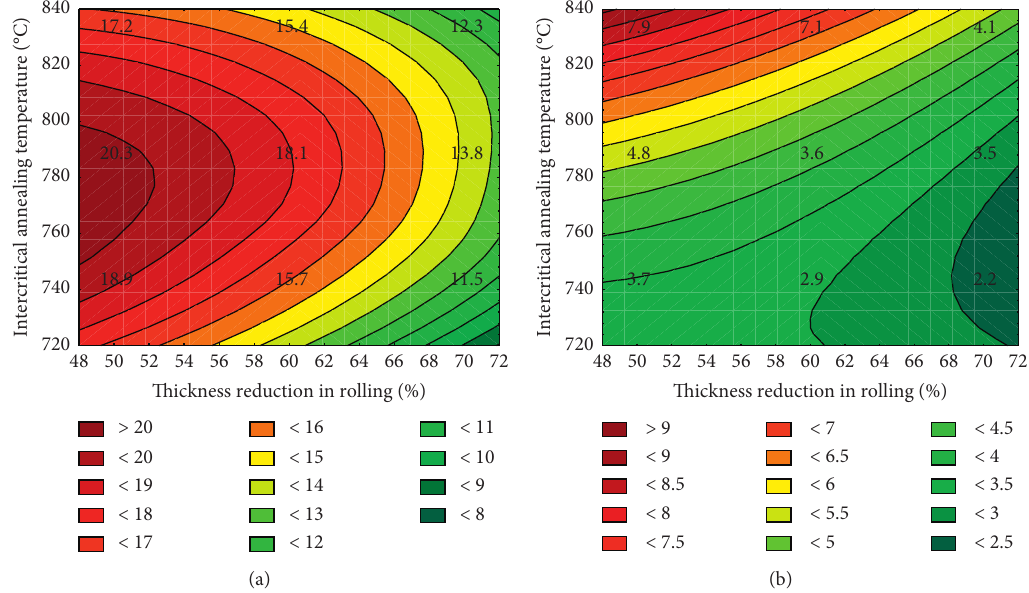
Figure 8: Effects of thickness reduction and annealing temperature on ferrite and martensite grain size: (a) ferrite; (b)